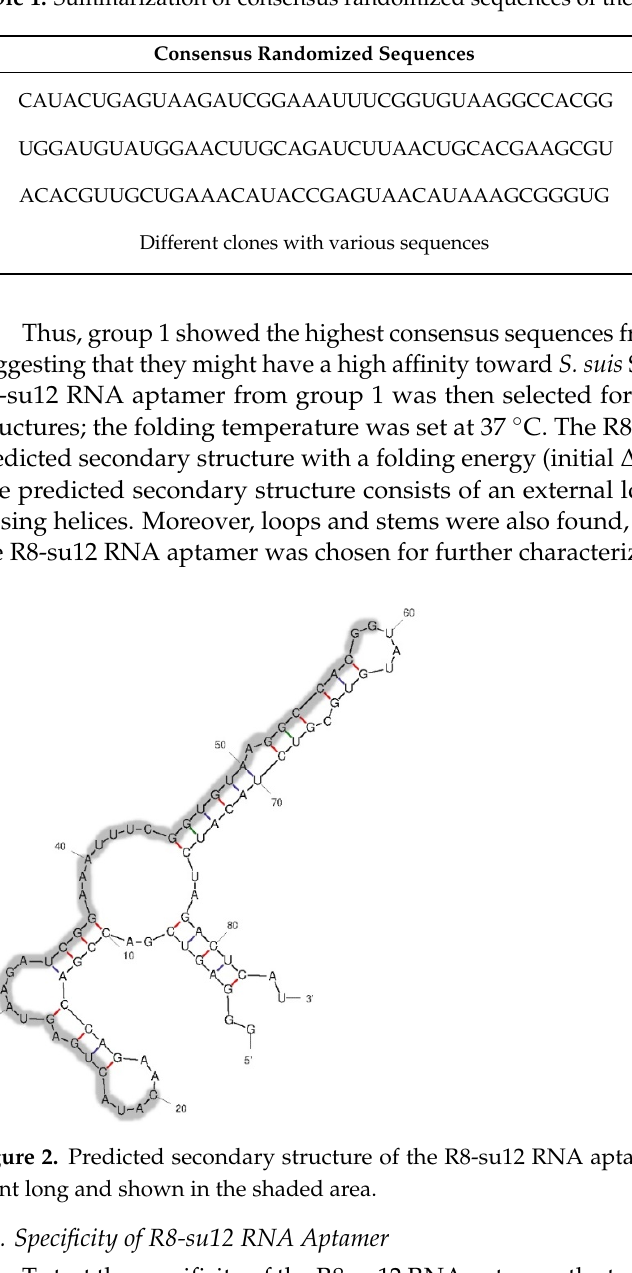
Table 1. Summarization of consensus randomized sequences of the RNA R8 aptamer pool.